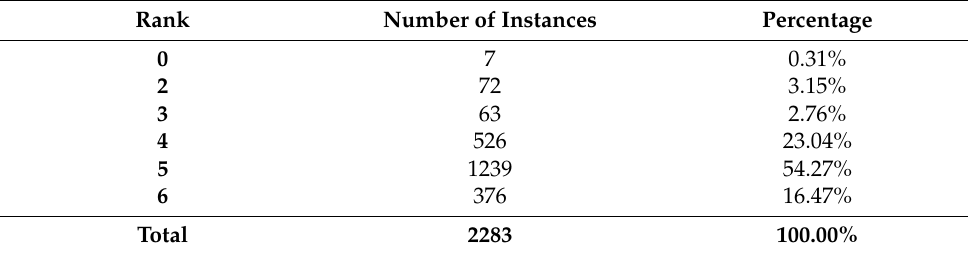
Table 1. Ranking Distribution with